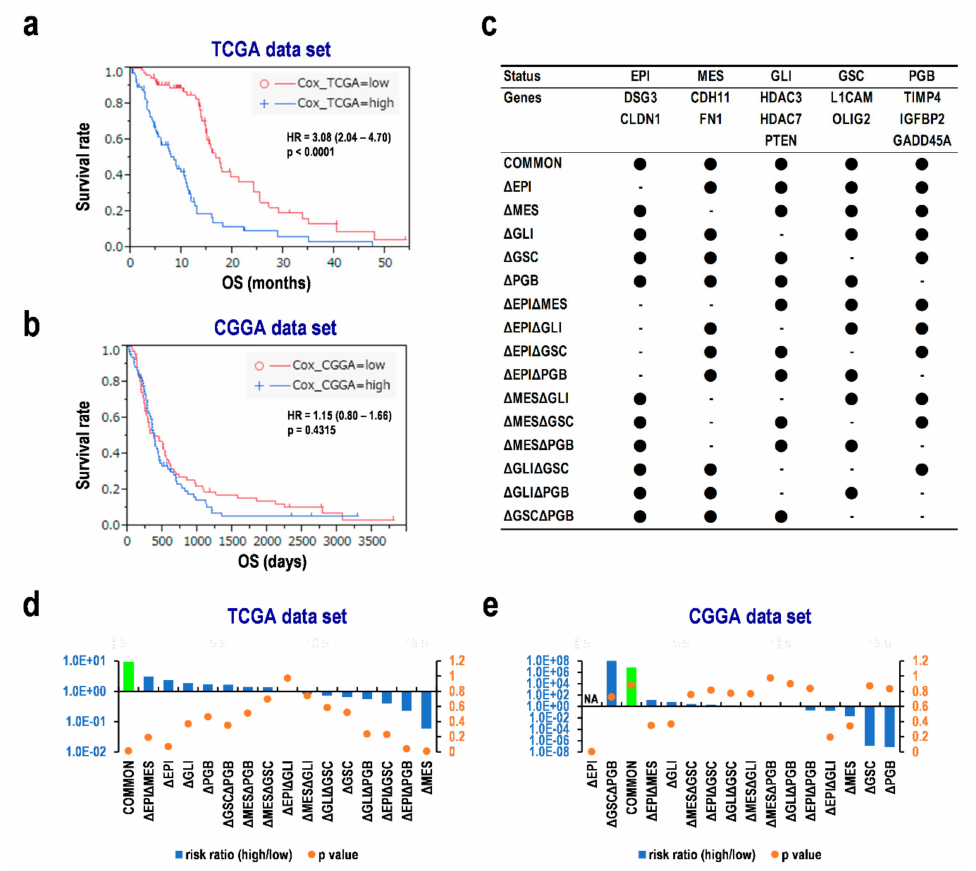
Figure 6. Contributions of EMT status and glioma stem cell markers for prognosis prediction in glioblastoma. ( a – b ) Survival distribution estimated with the combinatorial equation for prognosis prediction. ( a ) The Cancer Genome Atlas (TCGA) data set. ( b ) The Chinese Glioma Genome Altas (CGGA) data set. Subgroups were divided by the median score from the formula in the data set. ( c ) The formula composition. ( d – e ) The risk ratios and p -values in the subgroups with a high score compared with those with a low score. ( d ) The TCGA data set. ( e ) The CGGA data set. EPI, epithelial status; MES, mesenchymal status; GLI, glioma markers; GSC, glioma stem cell markers; PGB, potential glioma biomarkers; NA, not applicable; HR, hazard ratio. Delta ( ∆ ) represents a di ff erence